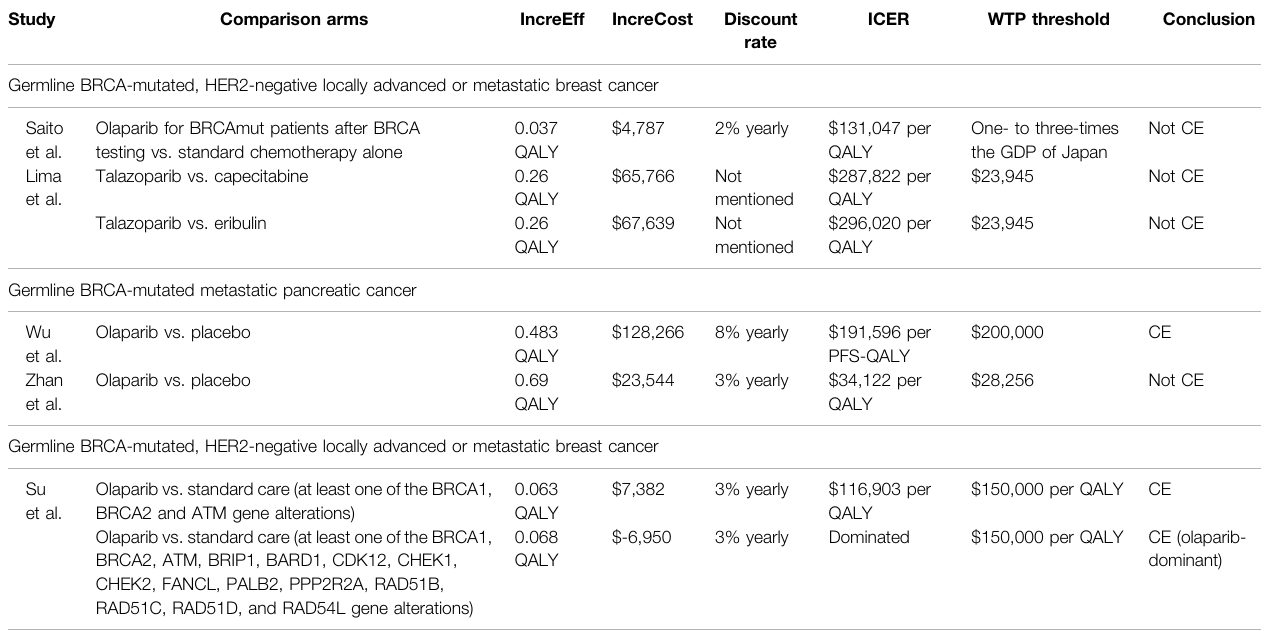
TABLE 4 | Details of economic evaluation outcomes of studies in other